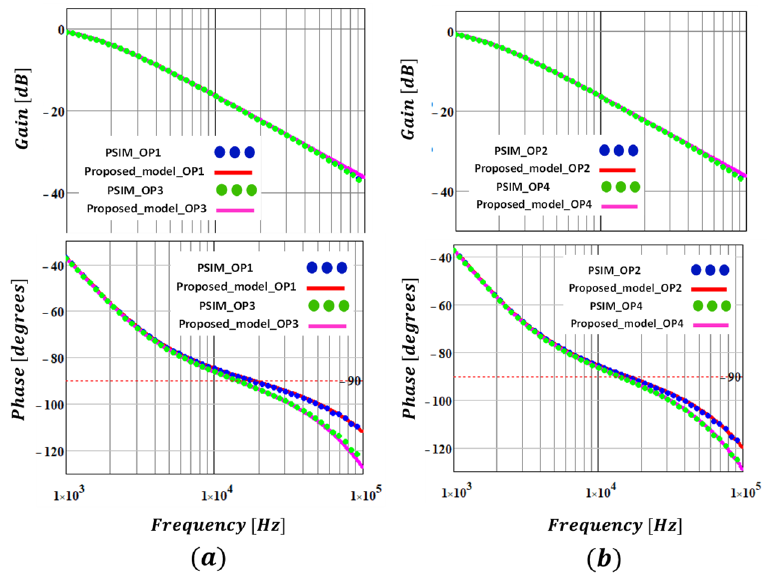
Figure 9. Comparison of the frequency response. ( a ) Operating point 1 and 3. ( b ) Operating point 2 and 3.